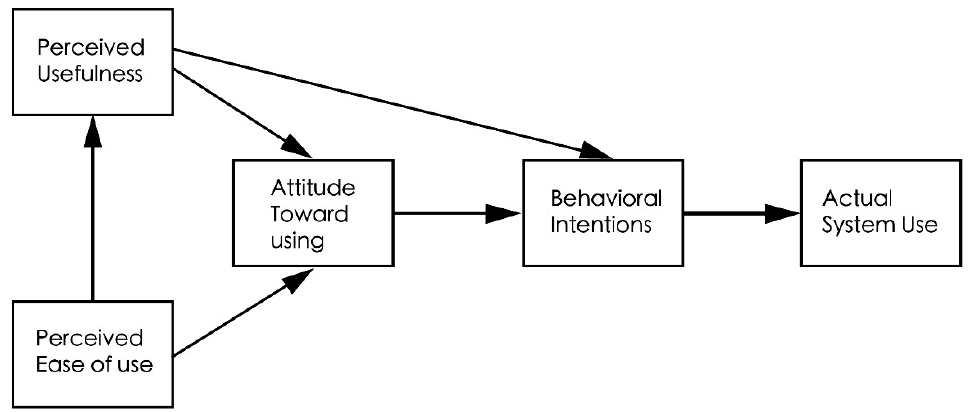
Figure 1. Technology acceptance model.